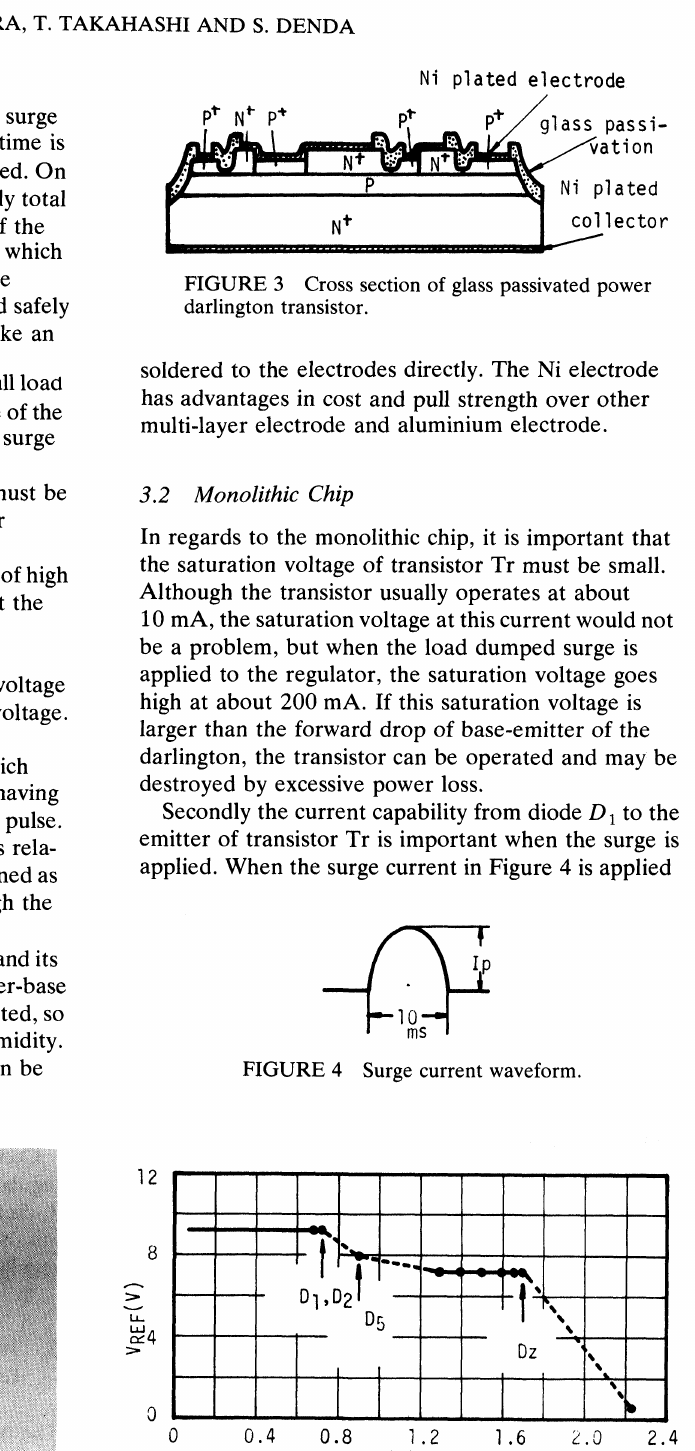
FIGURE 5 Surge capacity measurement, VRE with